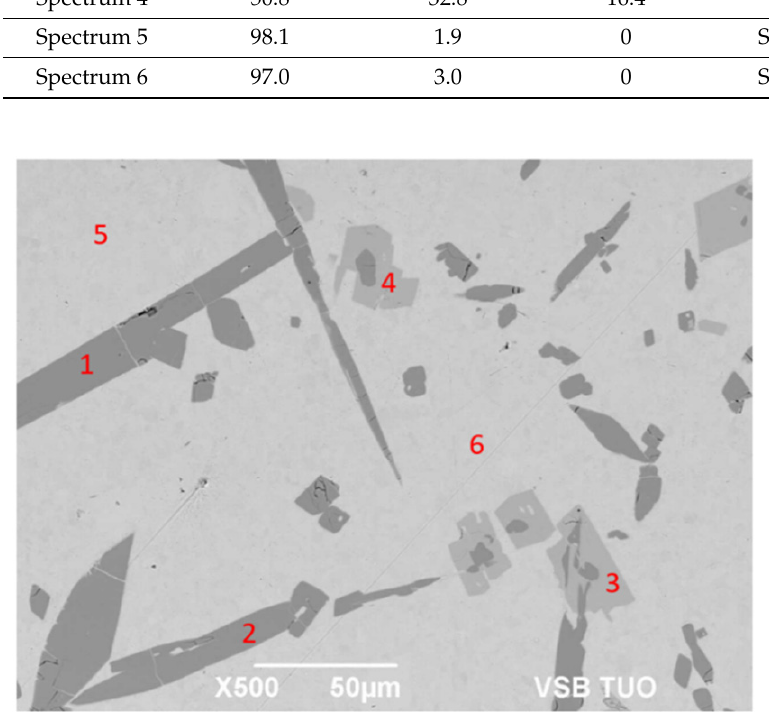
Figure 11. Representation of measuring points of the Sn5Sb3Ti Figure 11 . Representation of measuring points of the Sn5Sb3Ti solder. Table 5 . EDX analysis of the Sn5Sb3Ti solder .